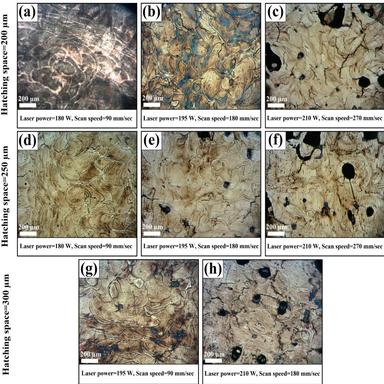
Effects of hatch space at three different levels of (a-c) 200, (d-f) 250, and (g, h) 300 µm at a constant layer thickness of ~ 20 µm on the soundness and integrity of LPBF deposited nanocomposite structures by varying the laser printing power in the range of 180–210 W and scan speed in the field of 90–270 mm/sec.